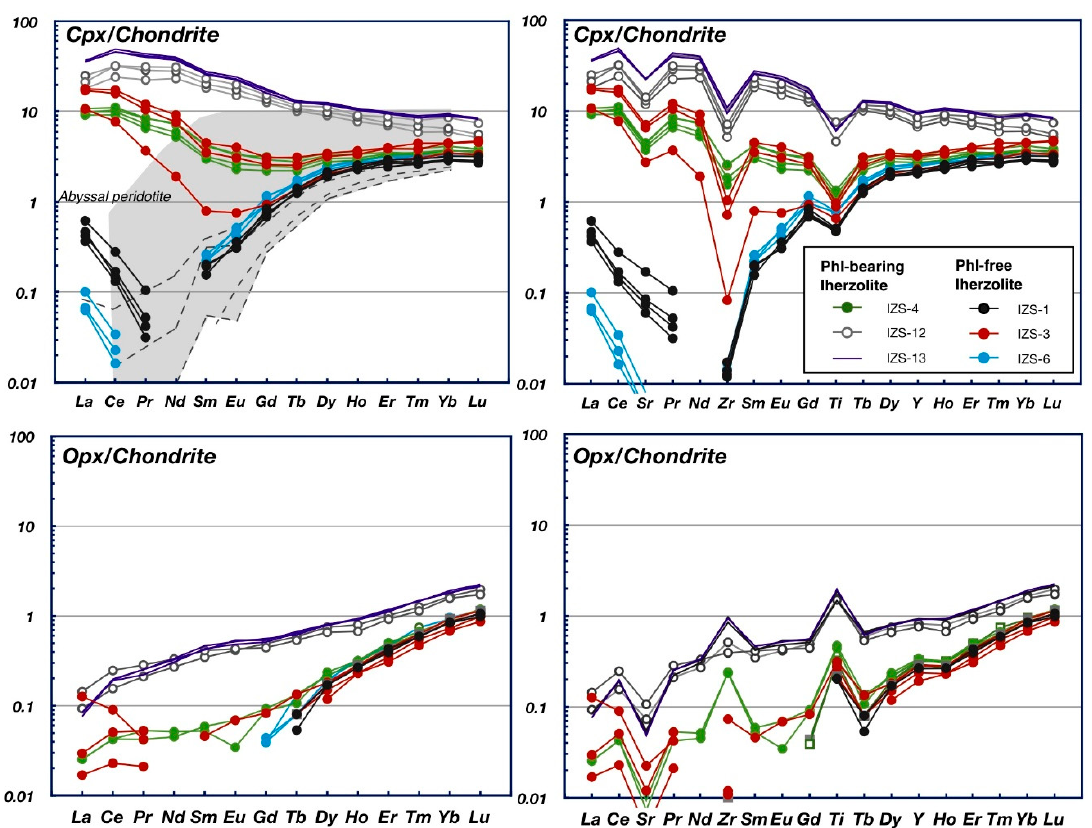
Figure 11. Chondrite-normalized REE and trace-element patterns of pyroxenes in the Bankawa lherzolite. ( a , b ) Clinopyroxene. ( c , d ) Orthopyroxene. Normalization values from Sun and McDonough [65]. Abyssal peridotite field (grey in ( a )) is compiled from Johnson et al. [86], Johnson and Dick [87] and Hellebrand et al. [88]. Some examples of the clinopyroxne pattern in depleted abyssal peridotite are shown by broken lines for comparison.